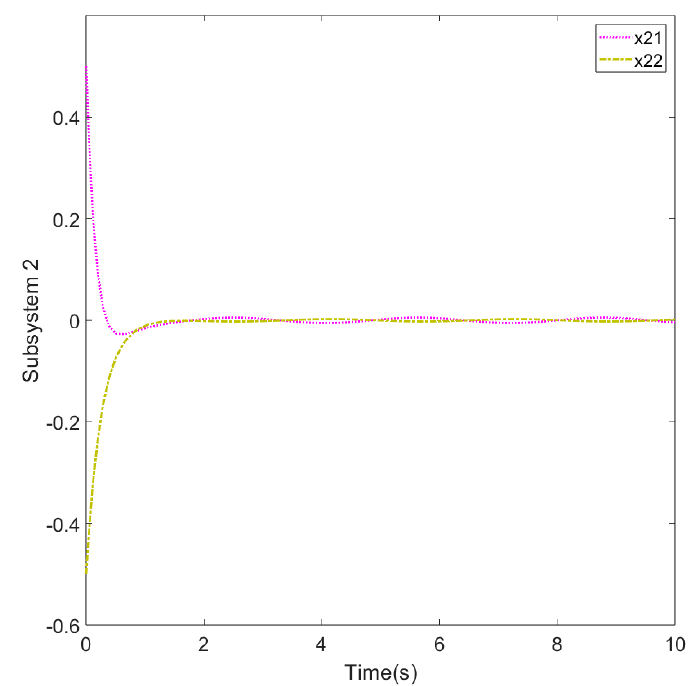
x for Example 1. 1